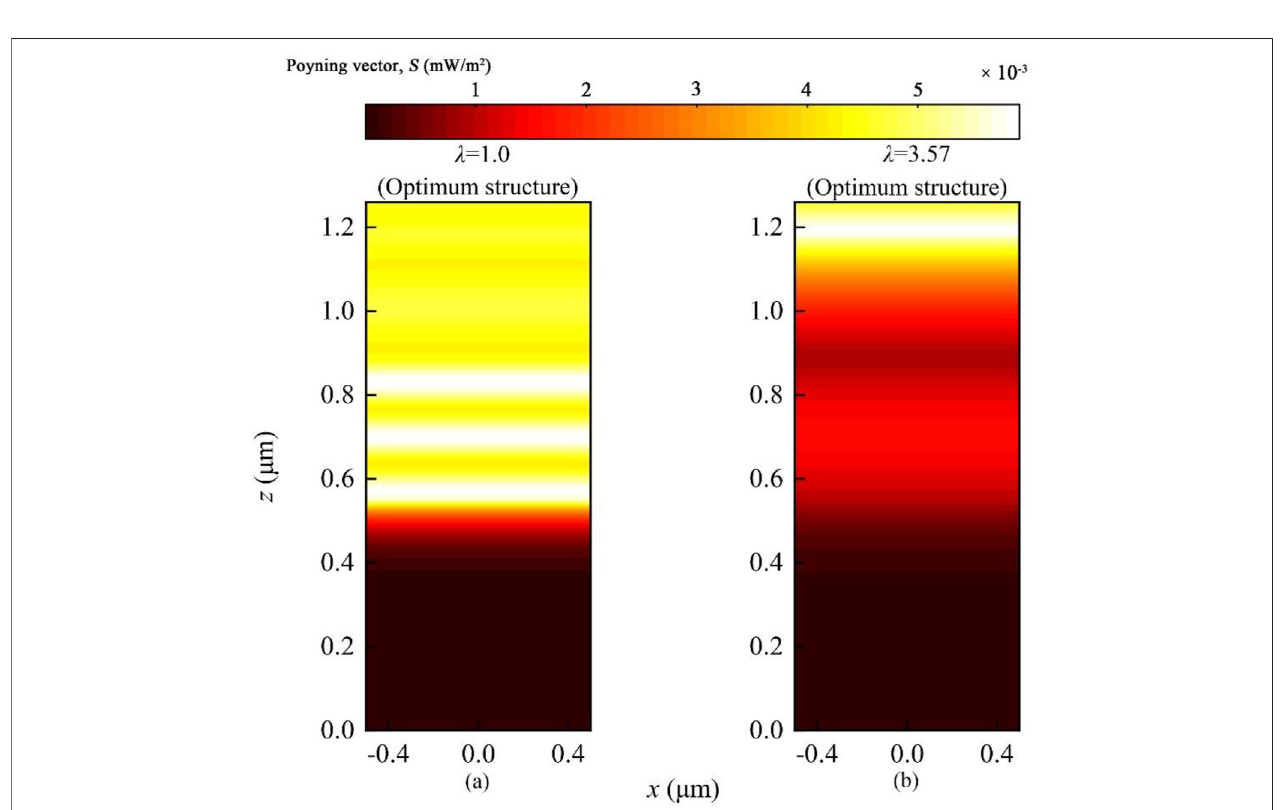
FIGURE 5 | The Poynting vector distribution of the proposed multilayer fi lm at different wavelengths of 1 and 3.57 µm.